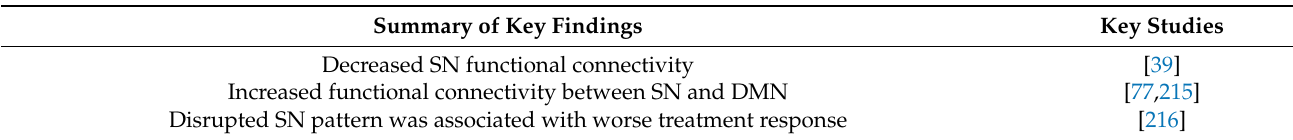
Table 5. Summary of key findings of rs-fMRI studies associated with the salience network (SN) in late-life depression (LLD) patients included in the